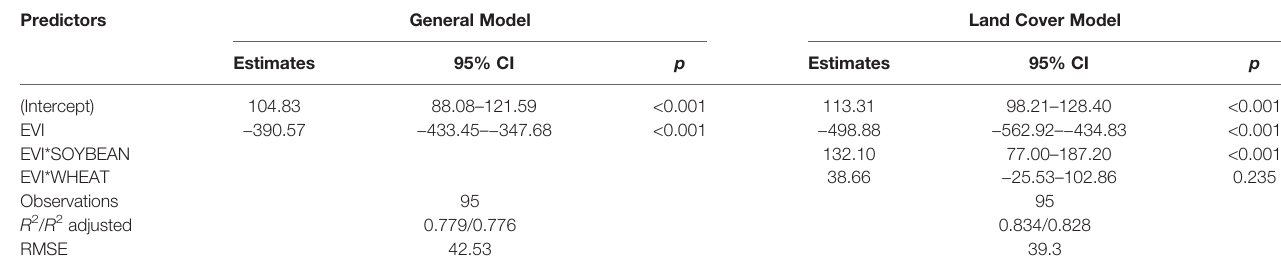
TABLE 2 | General and land cover model parameters estimates, con fi dence interval, p -values, and fi t criteria.